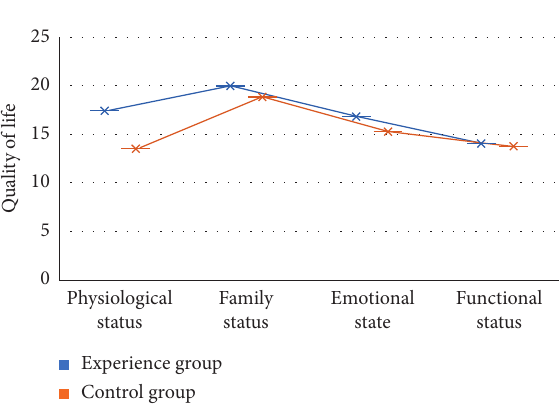
Figure 3: Effect of football intervention on sleep quality.